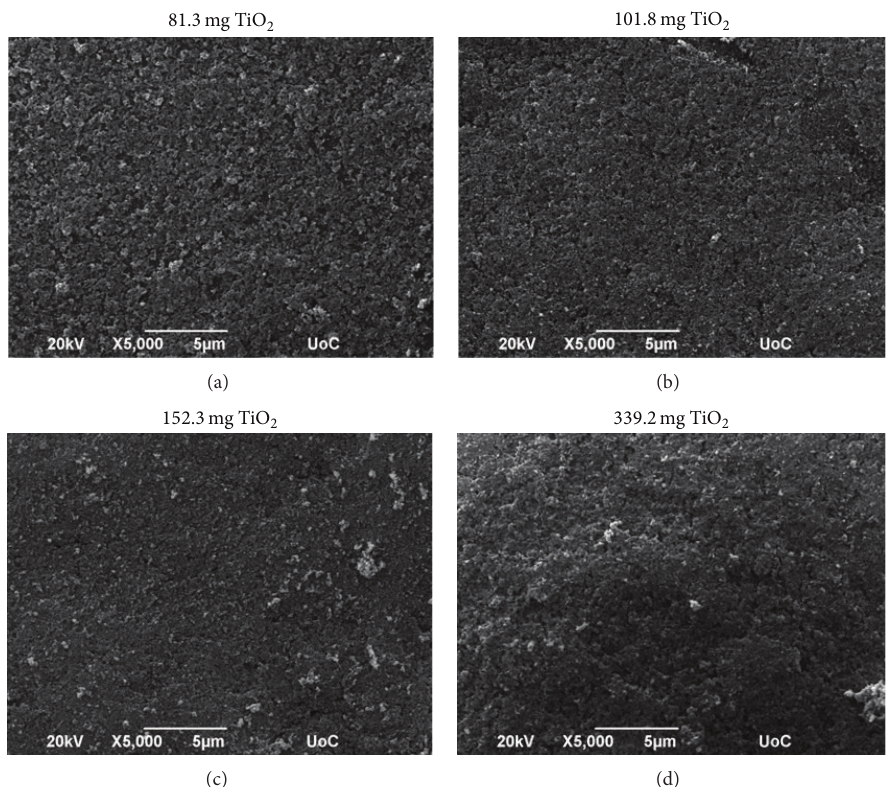
Figure 2: SEM images of TiO 2 immobilized particles on glass plate with increasing amount of catalyst from 81.3 to 339.2 mg (36.1 to 150.7 mg/cm 2 ).